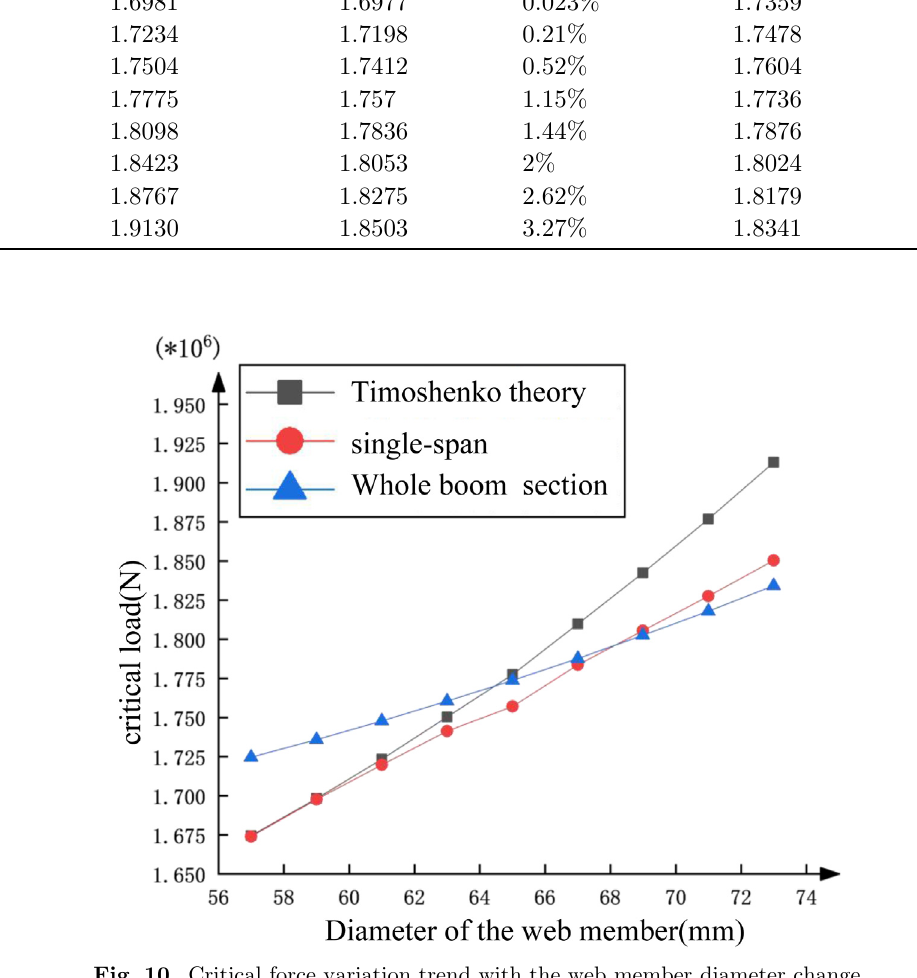
Fig. 10. Critical force variation trend with the web member diameter